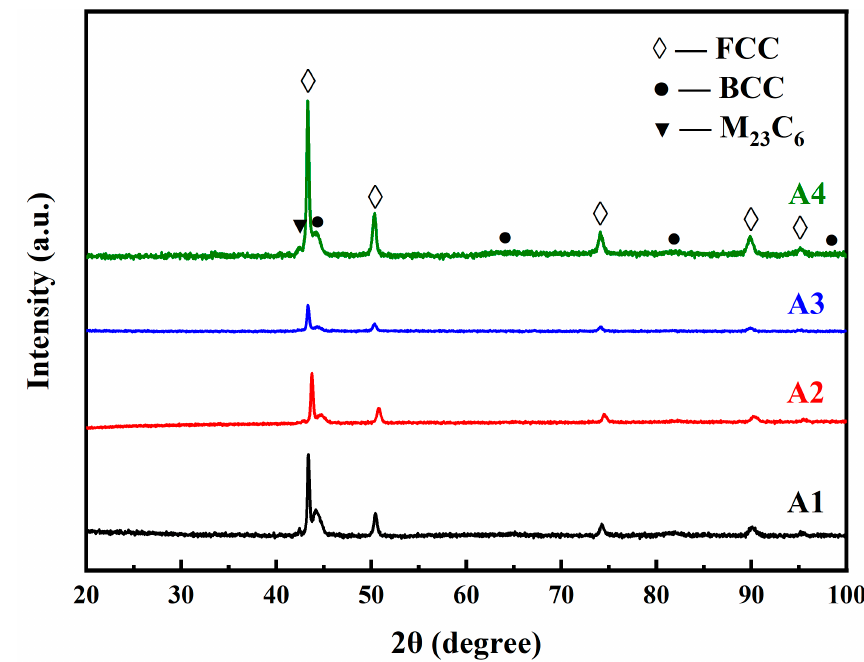
Figure 9. XRD patterns of the sintered specimens.